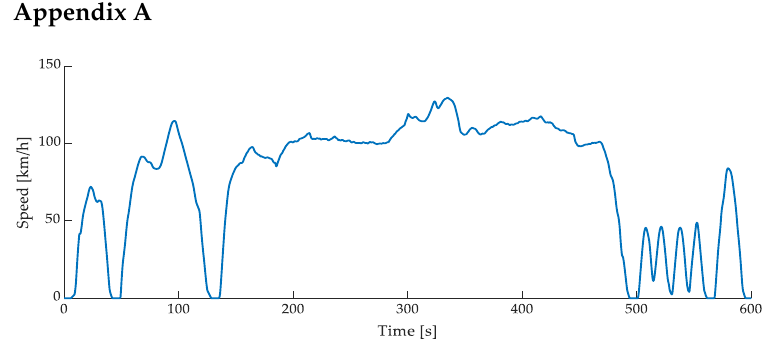
Figure A1. Speed profile over time of the aggressive US06 drive cycle.